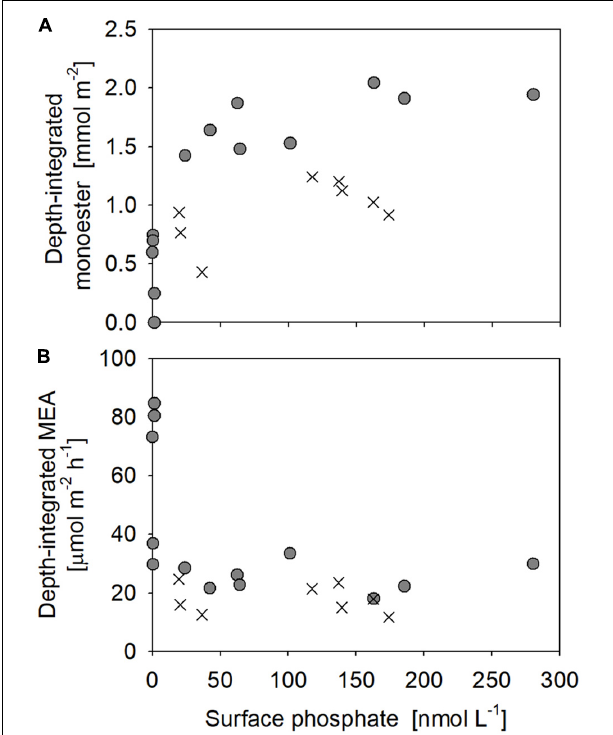
FIGURE 6 | Relationships between surface phosphate concentrations vs. depth-integrated (A) monoester concentrations and (B) monoesterase activity (MEA) above 75 m. Filled circles represent the results obtained in this study (Stations 4–17), whereas crosses are those from Yamaguchi et al. (2019).